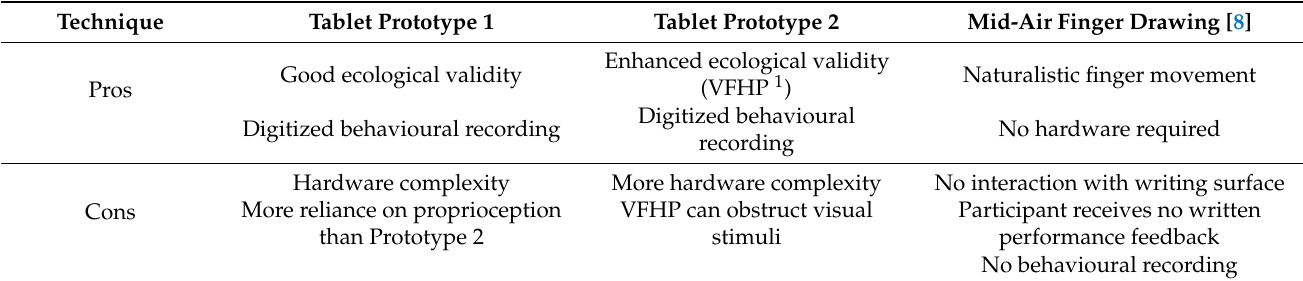
Table 1. Pros and cons of techniques for studying writing and drawing behaviour during fMRI.